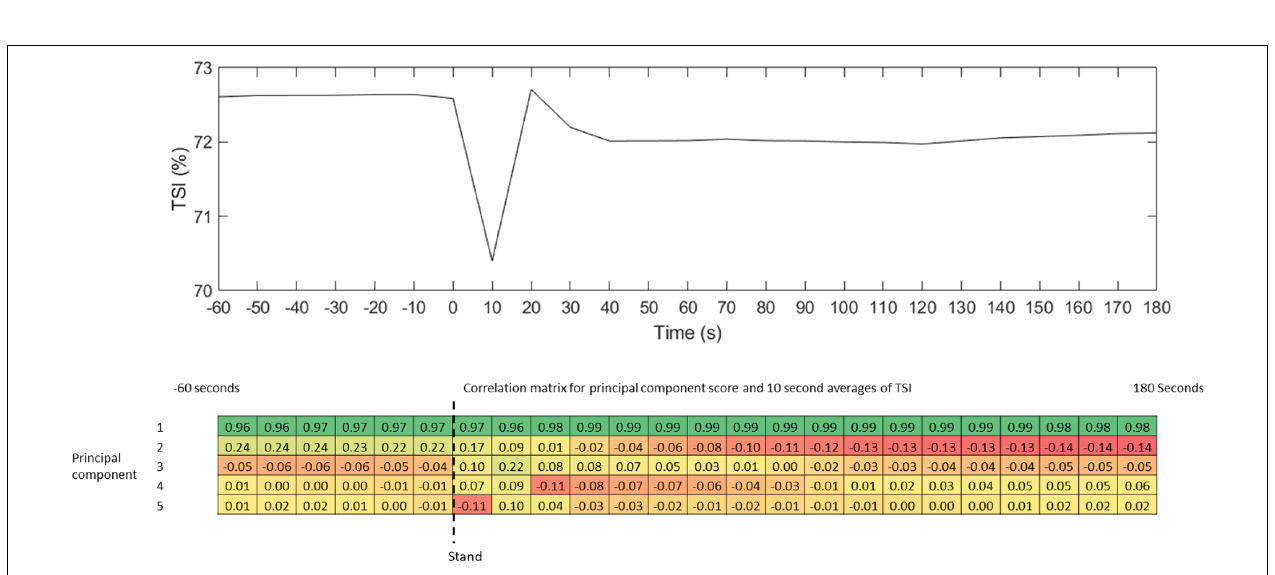
FIGURE 1 | Placement of knots located preferentially around the area of the signal expected to show variation based on the mean response and previous works.